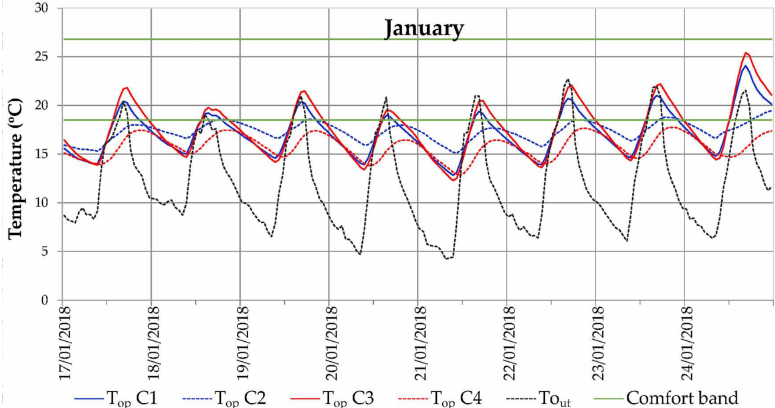
Figure 10. January protocol (continuous ventilation, 24 h): Daily evolution of operative temperatures in each cell compared to outdoor temperatures (see Supplementary Materials Figure